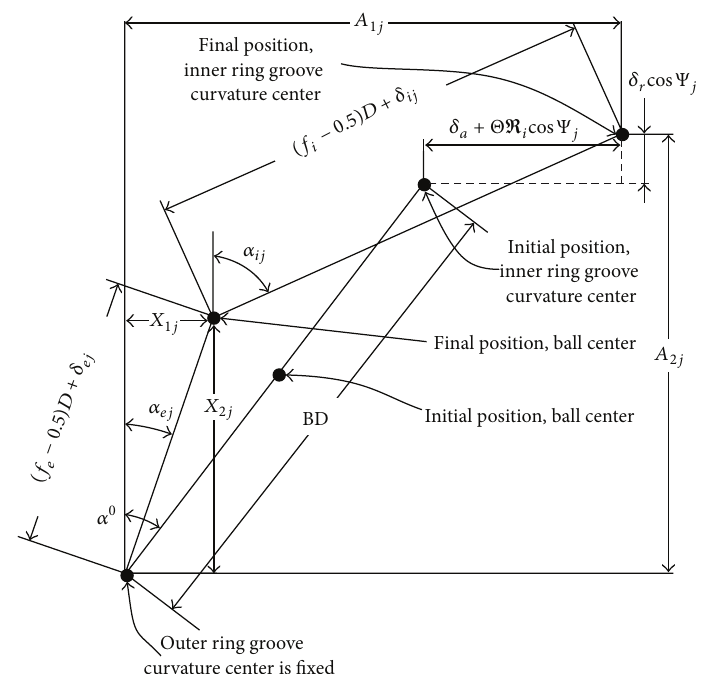
Figure 2: Deformed relationship between rolling element and rings.